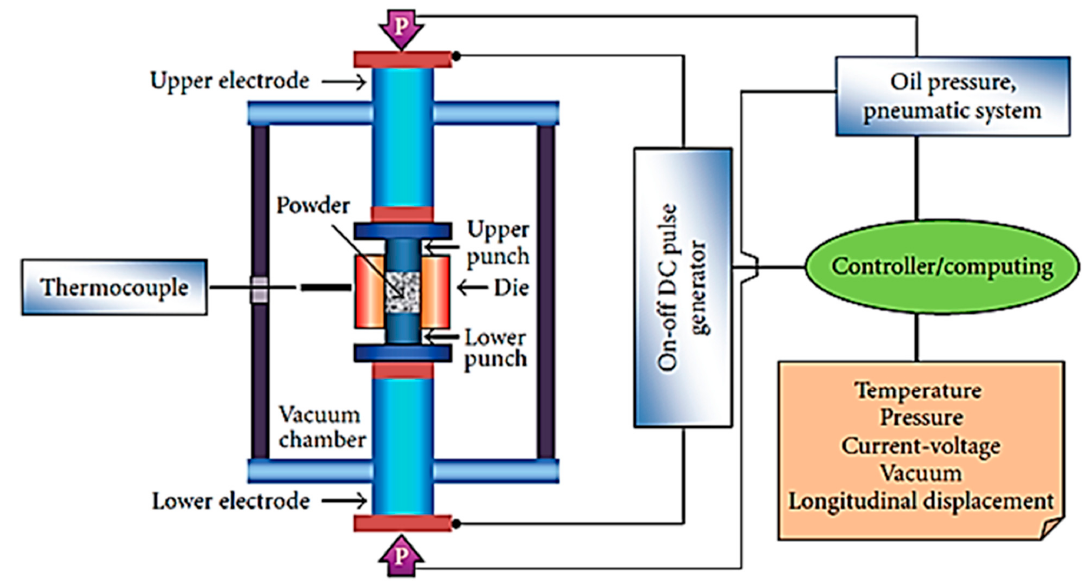
Figure 6 . Schematic of the SPS process. Reprinted with permission from